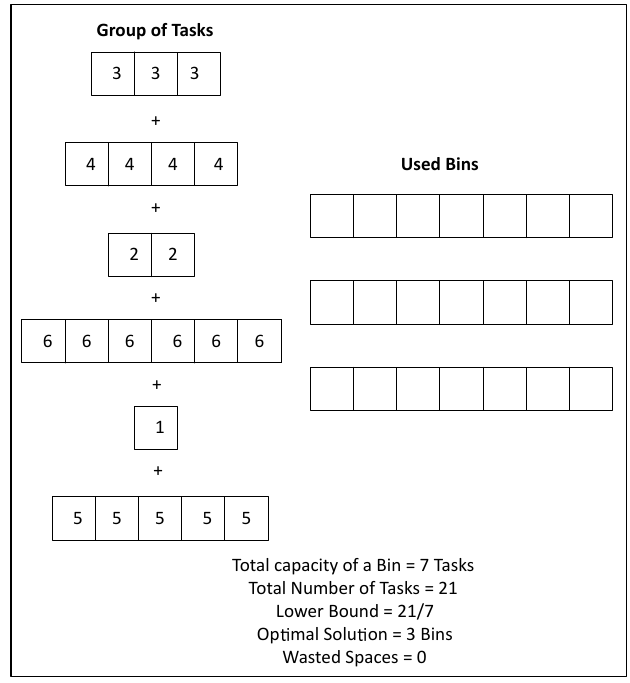
Figure 5. Lower Bound of a Problem.